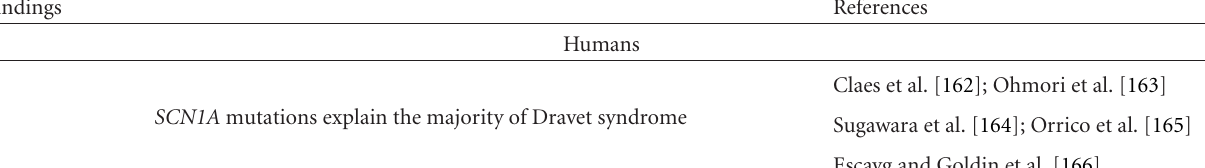
Table 3: Selected examples of genes causing epilepsy in humans and interneuron dysfunctions in mice.